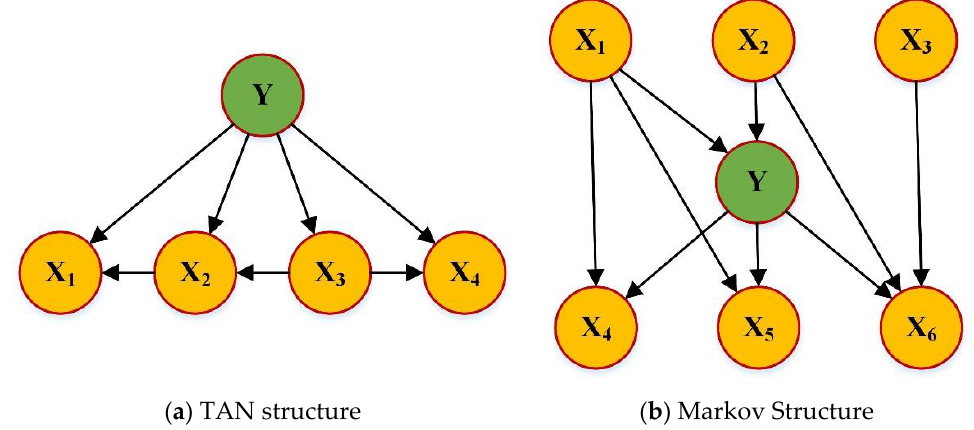
Figure 2. Structures of Tree Augmented Naïve (TAN) and Markov Blanket Networks.